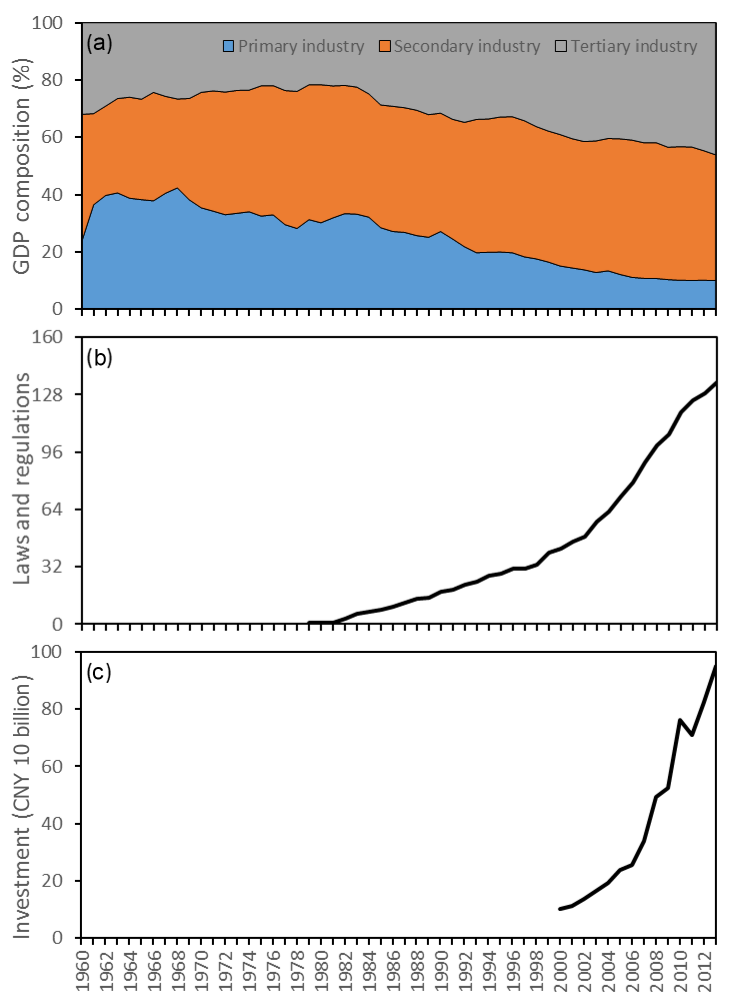
Figure 5. Annual trends in GDP composition (%; a ), accumulated number of laws and regulations related to air quality protection (b) , and investment in the treatment of environmental pollution (CNY10billion; c ) for 1960–2013 in China. Data for GDP composition and investment in the treatment of environmental pollution (available only from 2000 onward) are from the China Statistical Yearbook. Detailed information on the environmental laws and regulations is given by the data center of the Ministry of Environmental Protection of the People’s Republic of China